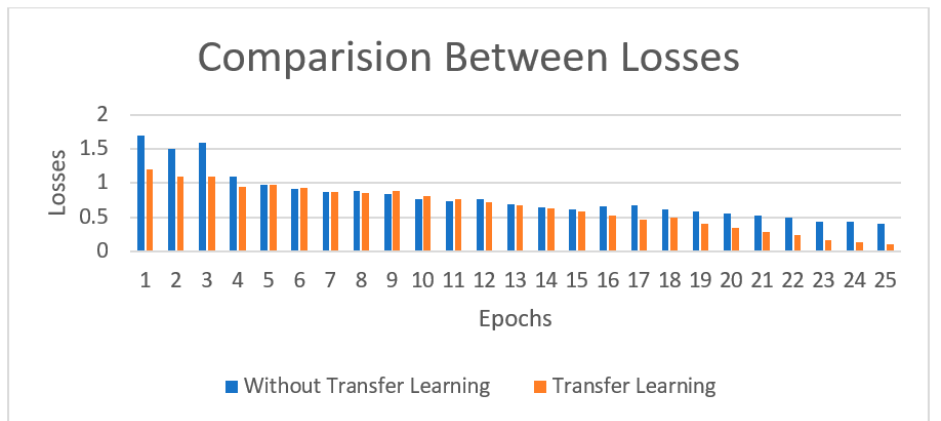
Figure 13. Comparison between losses with CASIA_v1 dataset. Table 4. Evaluation and characteristics of the proposed model.